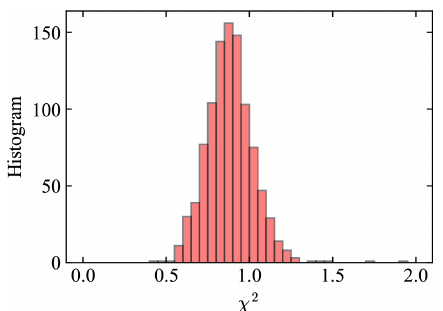
Figure 6. Histogram of the cost function values ( χ 2 ) with initial values as specified in Table 3 with a total of 1000 cases. The most probable χ 2 is 0.82. A threshold of χ 2 < 1 . 5 is used in the discus-